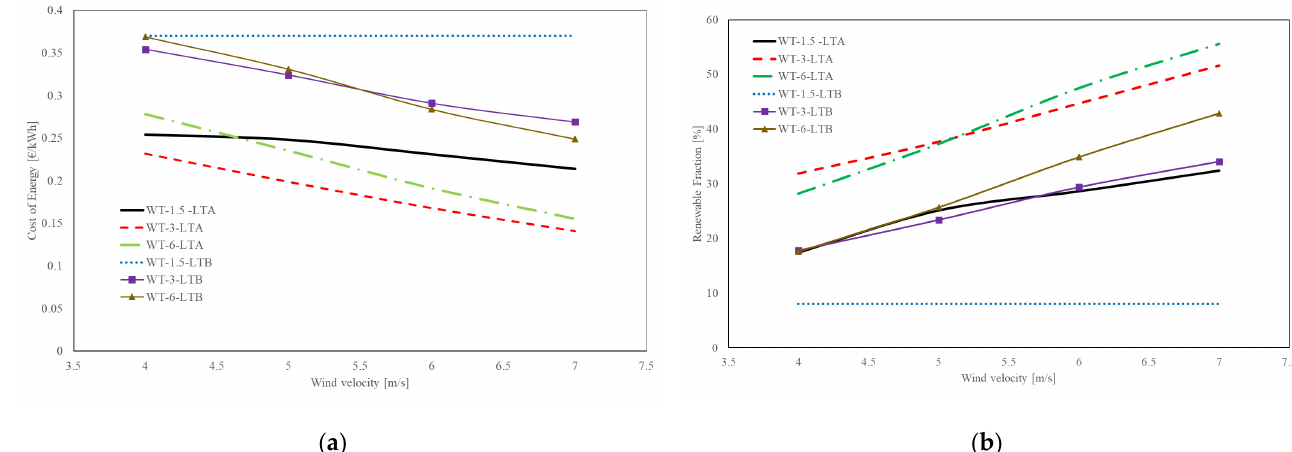
Figure 7. Wind potential parametric study for default wind pattern for different wind turbines. ( a ) COE vs. wind velocity; ( b ) Ren.Fr. vs. wind velocity